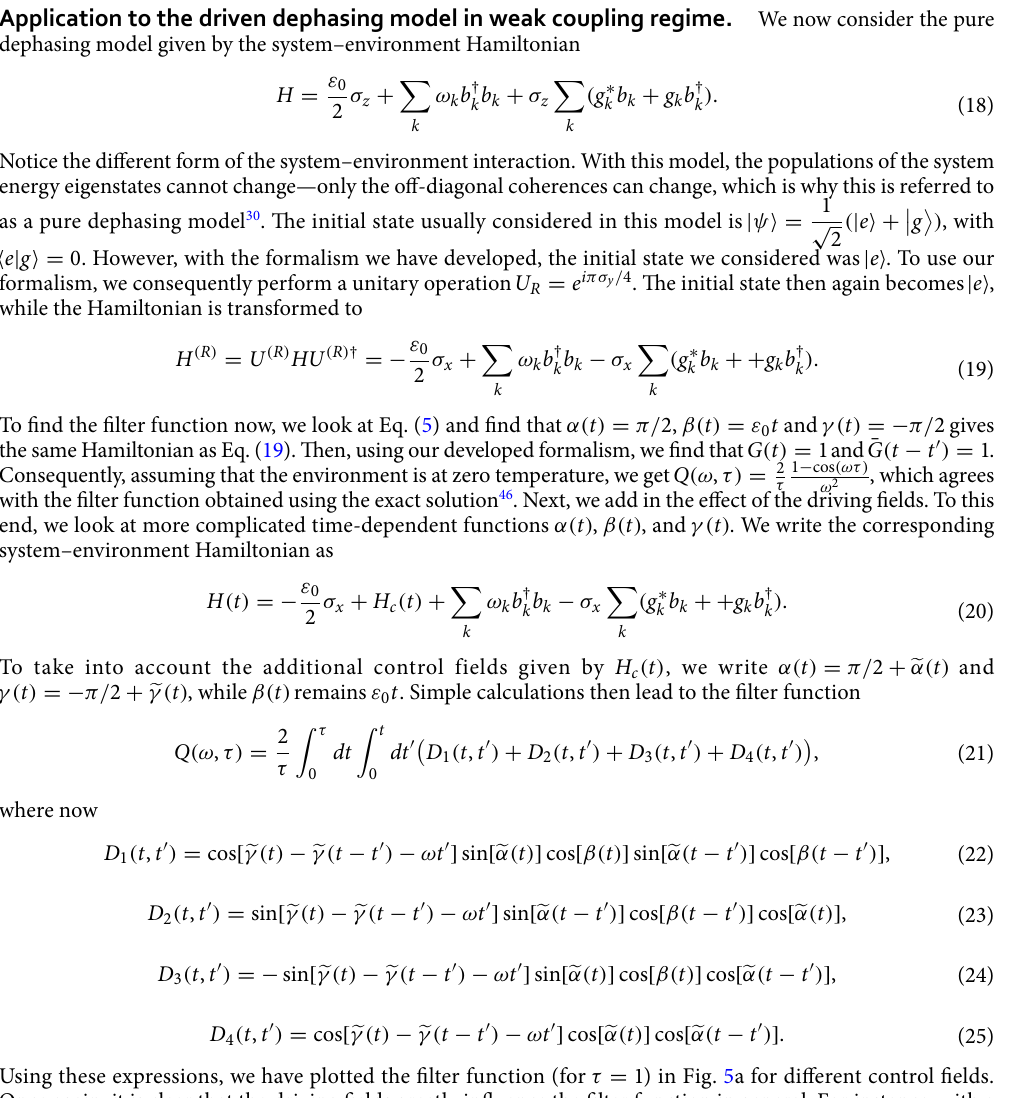
Figure 4. Filter function and effective decay rate for the driven population decay model without the RWA. ( a ) 1 )/χ ( e − χ t ε 0 t , β( t ) Graph of Q (ω , τ) versus ω in the presence of time-dependent driving fields: α( t ) = − − = 5 (dot- 0.2 (small-dashed, blue curve); α( t ) 0 with χ 0 with υ υ t and γ( t ) ε 0 t , β( t ) and γ( t ) = = = = = = 1 . 0 and γ( t ) 0 (solid, black curve). Here we have used τ ε 0 t , β( t ) dashed-dashed, orange curve); α( t ) = = = = 10 0.01 and ω c ( b ) Similar to ( a ), except that now we have plotted Ŵ(τ) versus τ with G = =